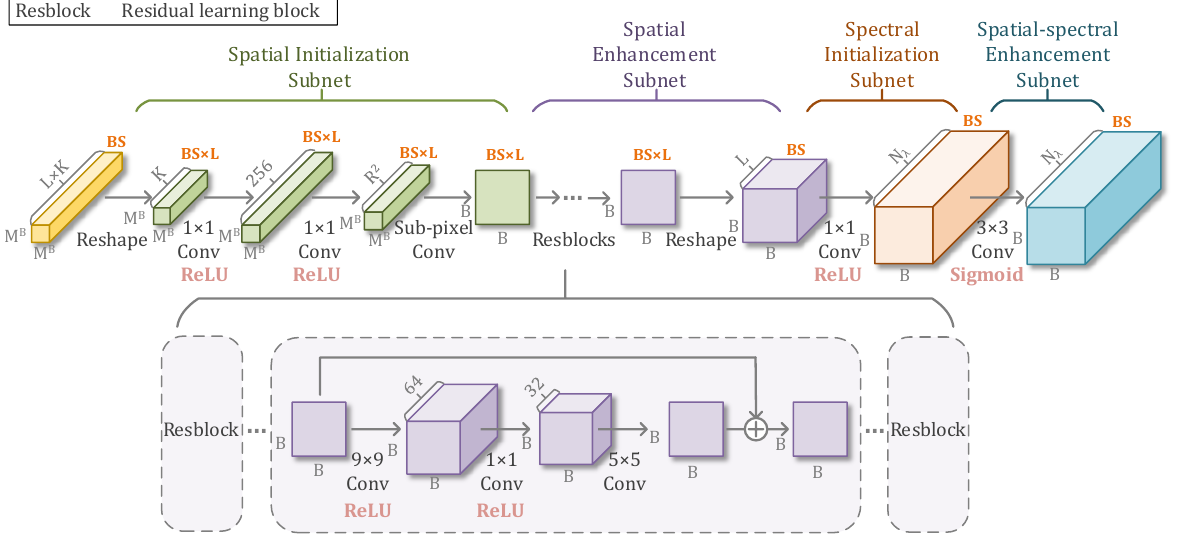
Figure 3. Overall architecture of the proposed backtracking reconstruction network (BTR-Net). The arrows denote different operations. Each box corresponds to a feature map, with the batch size denoted on top, the number of channels denoted at the topper left edge, and the x–y size provided at